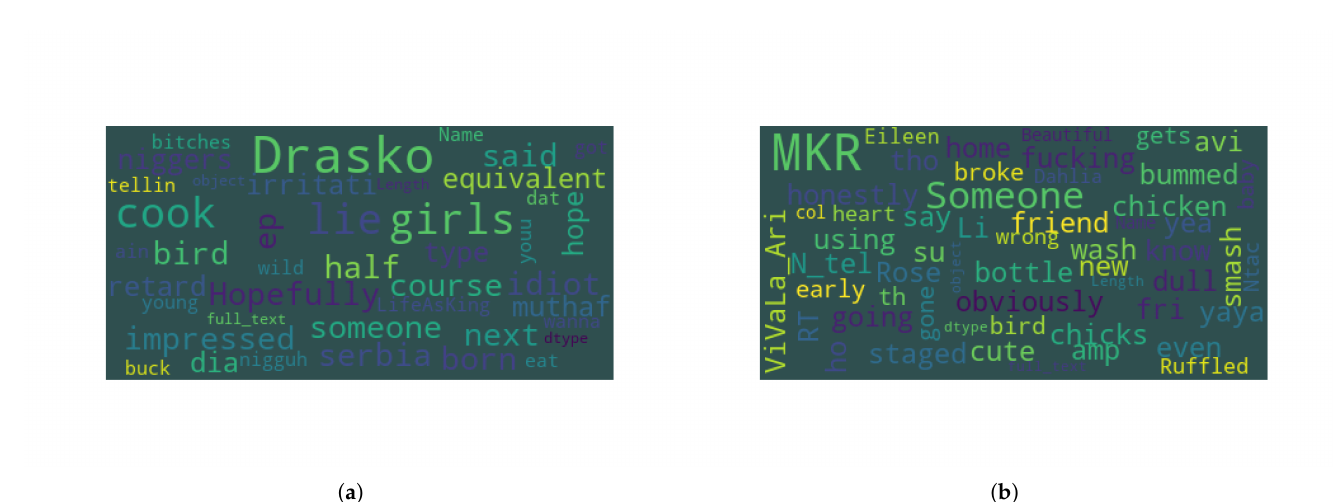
Figure 3. Word cloud of most frequent words in the dataset that belong to the two classes. ( a ) The most frequent words that belong to the offensive class. ( b ) The most frequent words that belong to the non-offensive class.